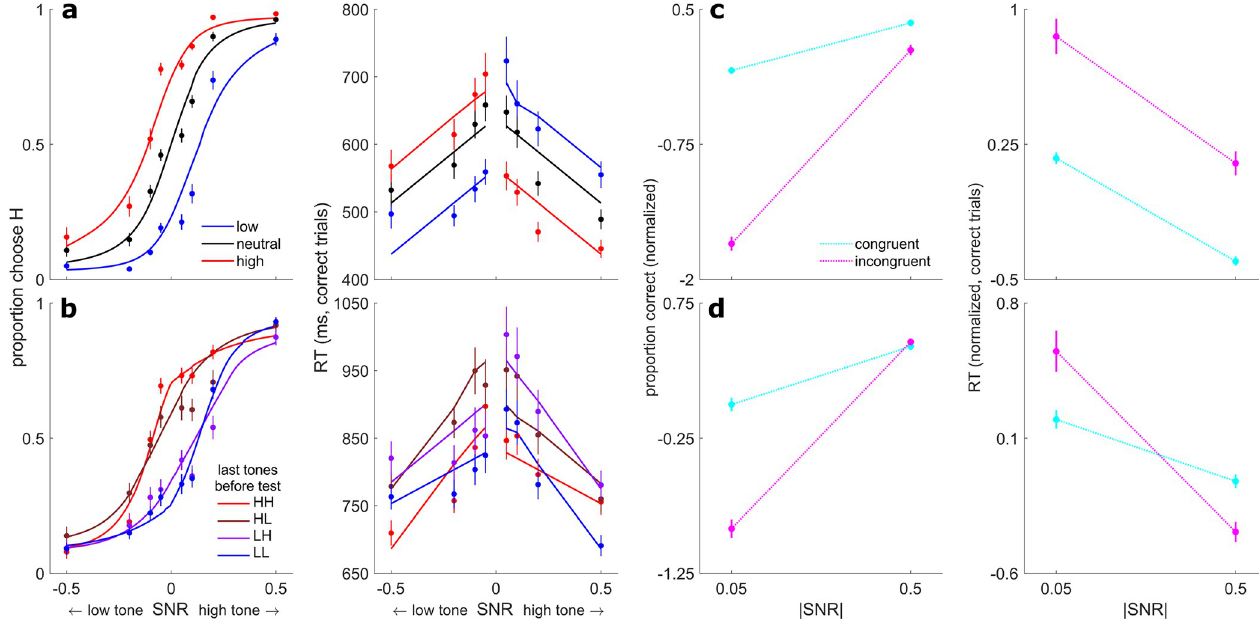
Fig 2. Behavioral summary. A Psychometric (left) and chronometric (right) functions from the rule-based condition for each prior cue (see legend). B Psychometric (left) and chronometric (right) functions from the stimulus-based condition for different patterns of the last two pre-test tones (see legend; HH = the last two tones were high, HL = the last tone was high and the second-to-last tone was low, etc.). By convention, negative and positive SNRs are low- frequency and high-frequency test tones, respectively. C Choice (left) and RT (right) interaction plots from the rule-based condition for trials in which the cue and test tone were “congruent” (e.g., a low cue followed by a low-frequency tone) or “incongruent” (see legend), at the lowest and highest unsigned SNRs. D Same as C , but for the stimulus-based condition. Here, only trials in which the last two pre-test tones were the same (HH and LL trials) were included in the analysis. In A–D , points are averages over subjects’ data, and error bars are standard errors of the mean (SEM). Within-subject RT averages in A and B were computed using medians, in accordance with the linear mixed-effects analysis. In C and D , choice and RT data were z-scored within subjects to facilitate comparisons. In A and B , solid lines are fits from the logistic (left) and linear (right) models for each condition (see text). Deviations of the RT fits from linearity are due to averaging predictions across subjects. In C and D , dotted lines are for visualization purposes only.